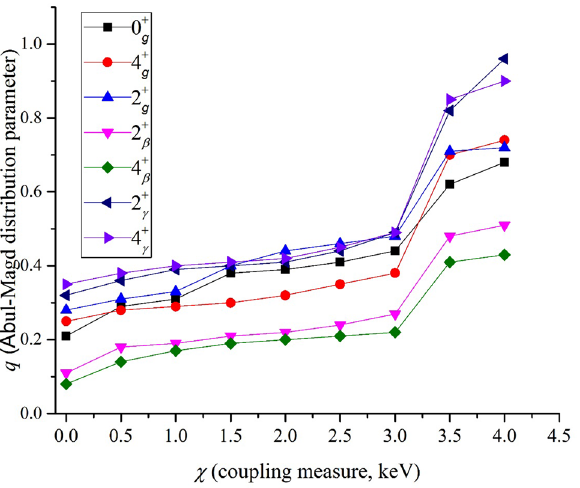
Figure 2. The variation of chaoticity degree, q values, for different energy levels determined by using different χ values in the QDS framework, Eq. (3), and A 1 = A 2 =